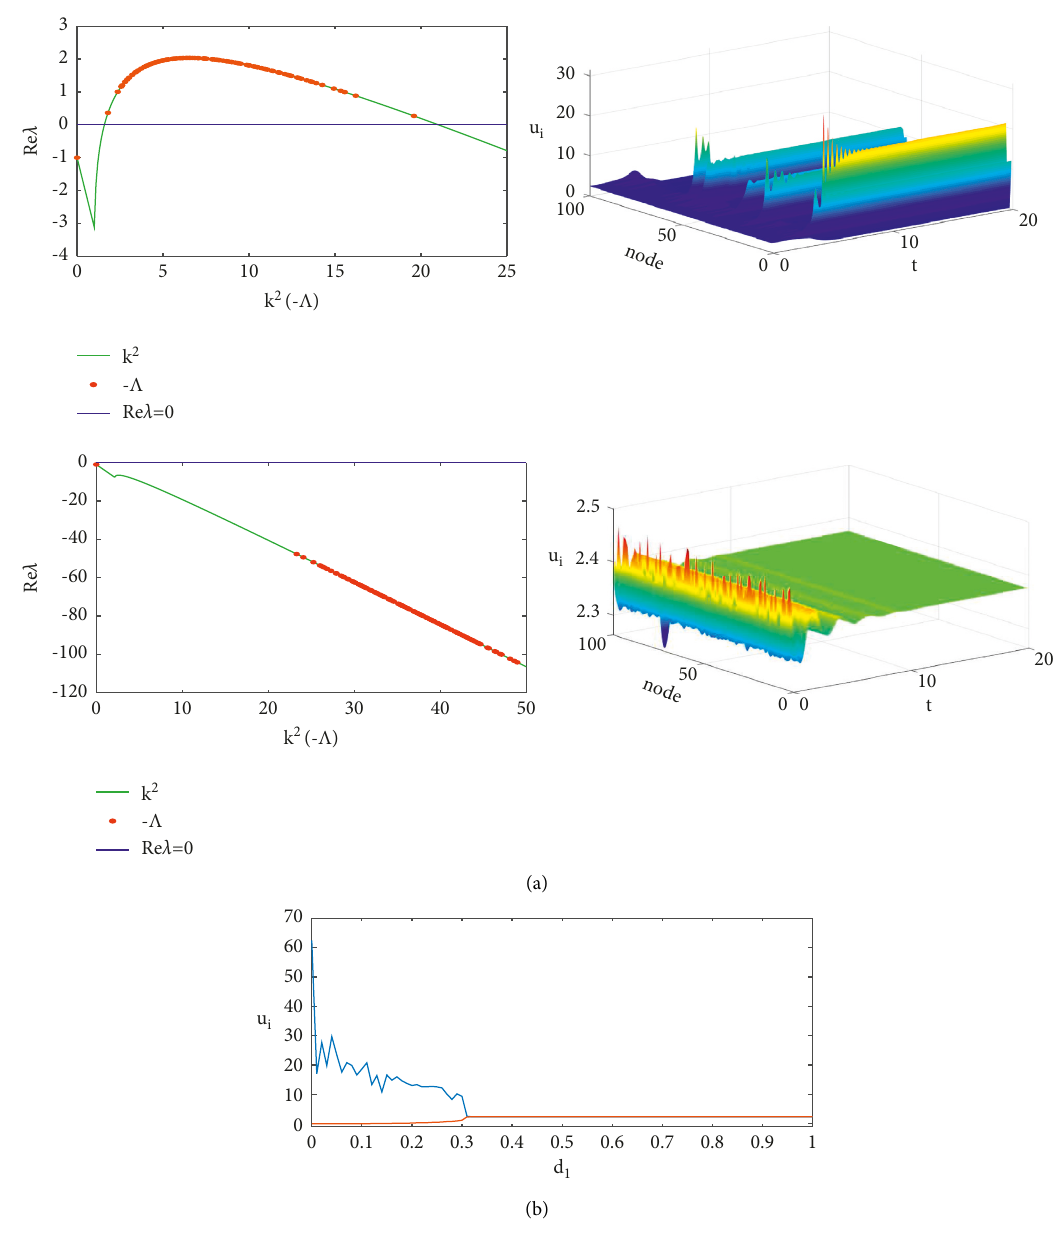
Figure 7: (a) The relationship between Re λ about − Λ ( k 2 ) (left) and the pattern formation of system (3) (right). Top: when i p � 0 . 08 ,d � 0 . 1124, almost all points Λ ( k 2 ) lie in the instability region and the Turing instability occurs. Bottom: when i 1 � 1 . 1124, no point Λ ( k 2 ) lies in the instability region and the system is stable. (b) The bifurcation occurs about d p � 0 . 08 ,d i 1 p � 0 .